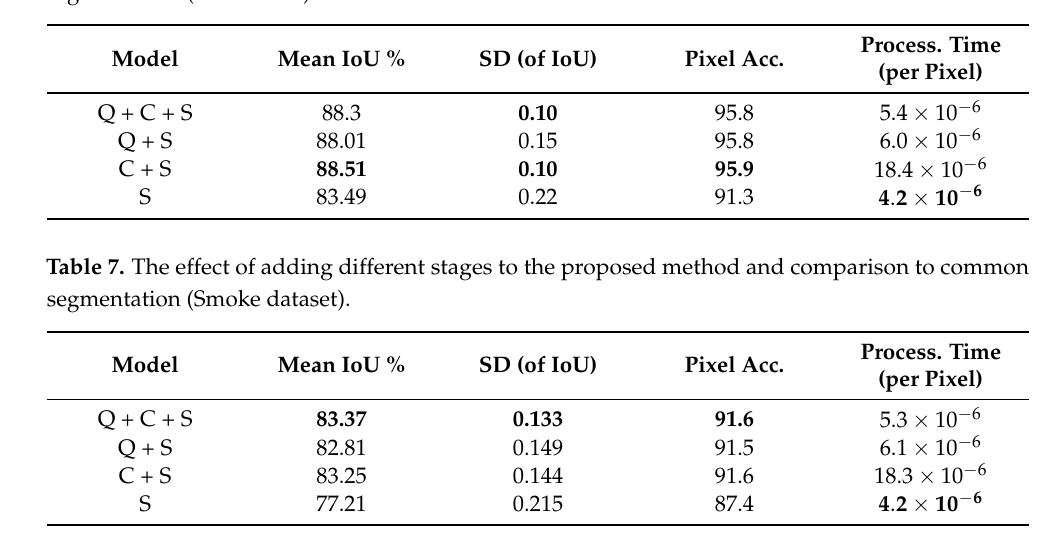
Table 6. The effect of adding different stages to the proposed method and comparison to common segmentation (fire dataset).